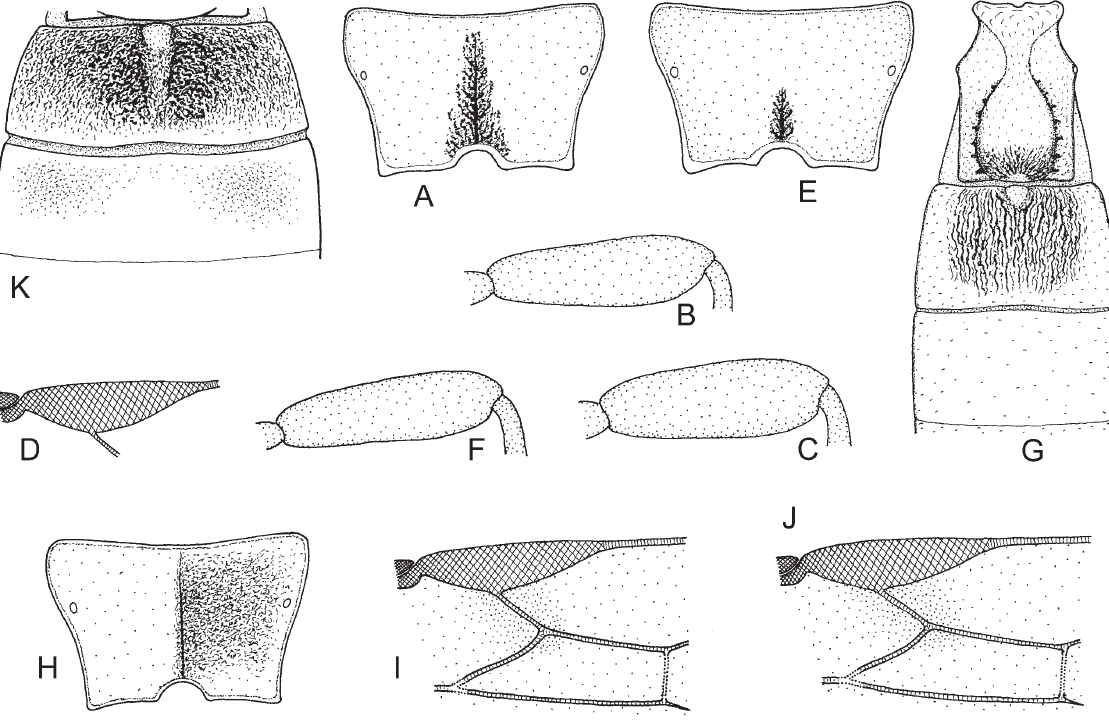
Fig. 58. — A-J . Bracon ( Glabrobracon ) exhilarator Nees, 1834 (= B. satanas Wesmael, 1838, A-D: ♀ paralectotype and E-G: ♂ paralectotype; B. exhilarator H-J: ♀ / ♂). A . Propodeum. B-C . Hind femur. D . Pterostigma of right forewing. E . Propodeum. F . Hind femur. G . Tergites 1-3. H . Propodeum. I-J . Pterostigma, r and second submarginal cell (I: 3-SR 1.3 times and J: 3-SR 1.5 times as long as 2-SR ). — K . Bracon ( Lucobracon ) erraticus var . superciliosus (Wesmael, 1838), ♀ holotype, tergites